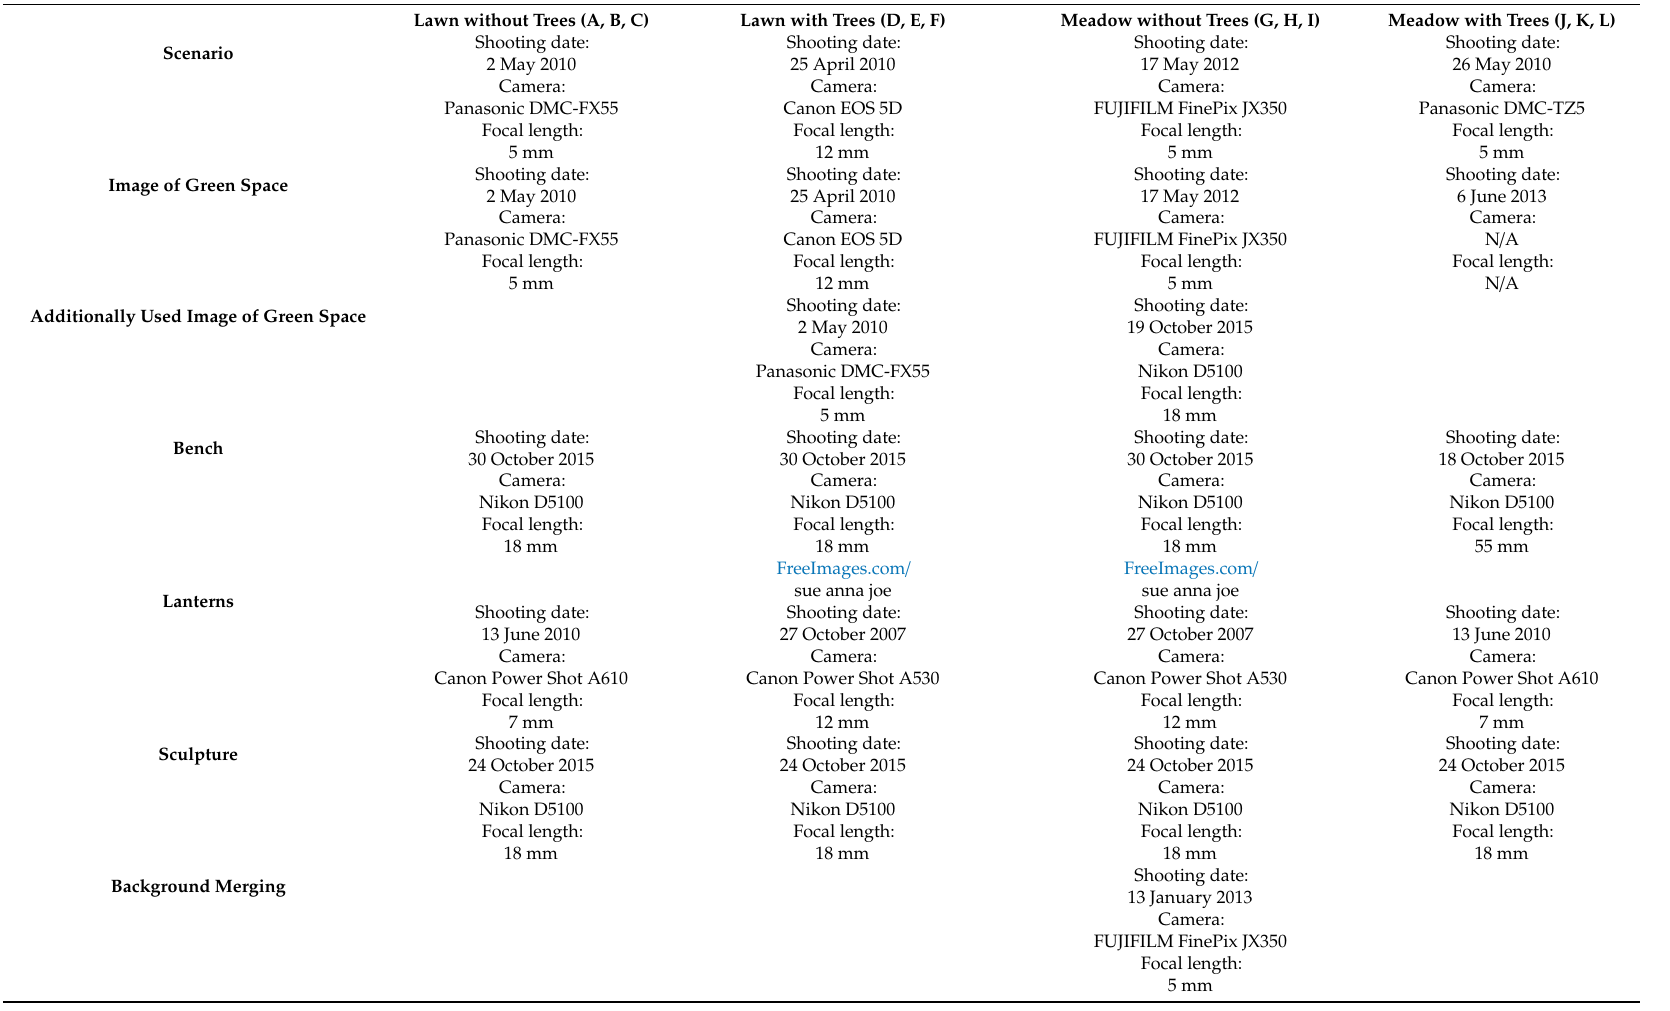
Table A9. Photo usage and details of Question